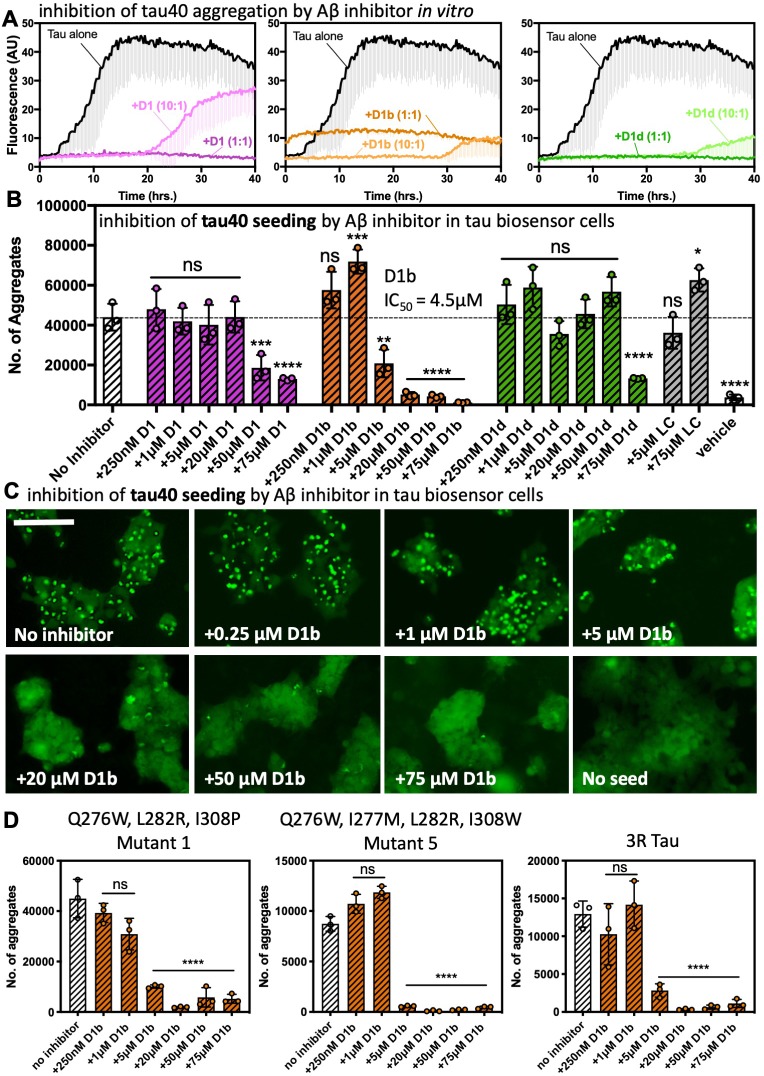
Aβ inhibitors also reduce fibril formation and seeding by tau40.(A) Peptide inhibitors D1, D1b, and D1d reduce fibril formation of tau40. 10 μM tau40 monomer was incubated at a 1:10, 1:1, or 10:1 molar ratio to each inhibitor with 0.5 mg/ml heparin under shaking conditions at 700 RPM at 37°C. Fibril formation was monitored using ThT fluorescence. Plots show the average of three technical replicates with one standard deviation below. (B), (C). The effects of the inhibitors on seeding by tau40 fibrils in tau-K18CY biosensor cells. The cells were seeded with 250 nM tau40 fiber (final concentration); in samples with inhibitor, tau40 fibers were incubated with indicated final concentrations of peptide inhibitor for one hour prior to addition to cells. (B) Average number of aggregates at the indicated inhibitor concentrations, Bars represent mean with individual technical replicates, error bars display one standard deviation (n = 3; ns = not significant; *, p<0.03; **, p<0.023; ***, p<0.0008; ****, p<0.0001 using an ordinary one-way ANOVA- Dunnett’s relative to leftmost column). dotted line represents number of aggregates from untreated tau40 fibrils. IC50 value was calculated from the dose–response plot of inhibitor D1b. (C). Representative images of effect of D1b on seeding. Cells are shown at 10X magnification, scale bar 100 μm. (D) Seeding from tau interface mutation fibrils in tau-K18CY biosensor cells is reduced by D1b. Experiment was performed as above. Average number of aggregates at the indicated inhibitor concentrations, Bars represent mean with individual technical replicates, error bars display one standard deviation (n = 3; ns = not significant; ****, p<0.0001 using an ordinary one-way ANOVA- Dunnett’s relative to leftmost column).10.7554/eLife.46924.026Figure 6—source data 1.Tau biosensor seeding data points—tau and tau interface mutations with and without inhibitor.